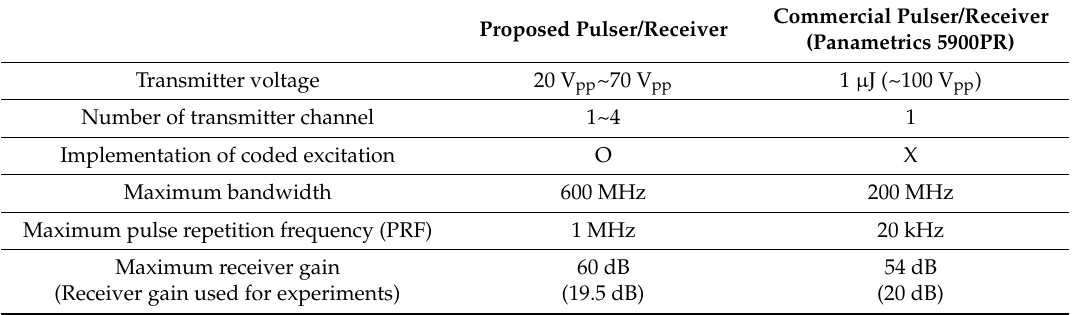
Table 1. Performance comparison between the proposed pulser/receiver and the commercial